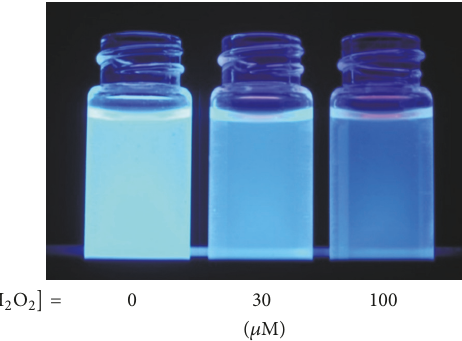
Figure 2: Visible change of the emission color from the aqueous solutions of polymer B-11 (10mg L −1 ) containing or not containing H 2 O 2